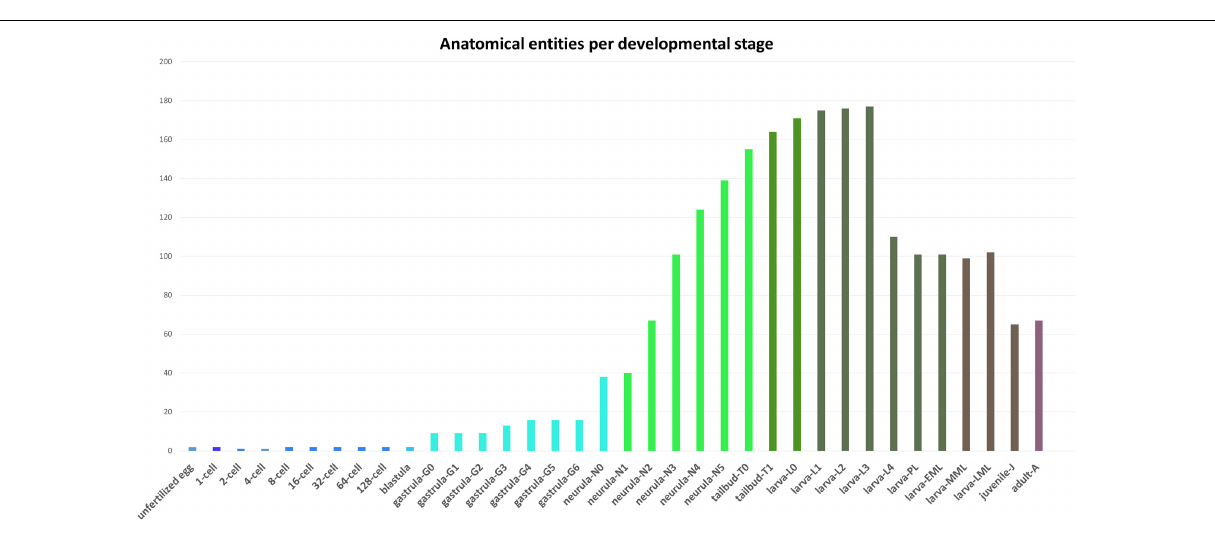
FIGURE 2 | Number of anatomical entities per developmental stage of Branchiostoma lanceolatum . The number of anatomical entities (Y-axis) in the unfertilized egg as well as at each developmental stage from the 1-cell stage to the adult stage (X-axis) is